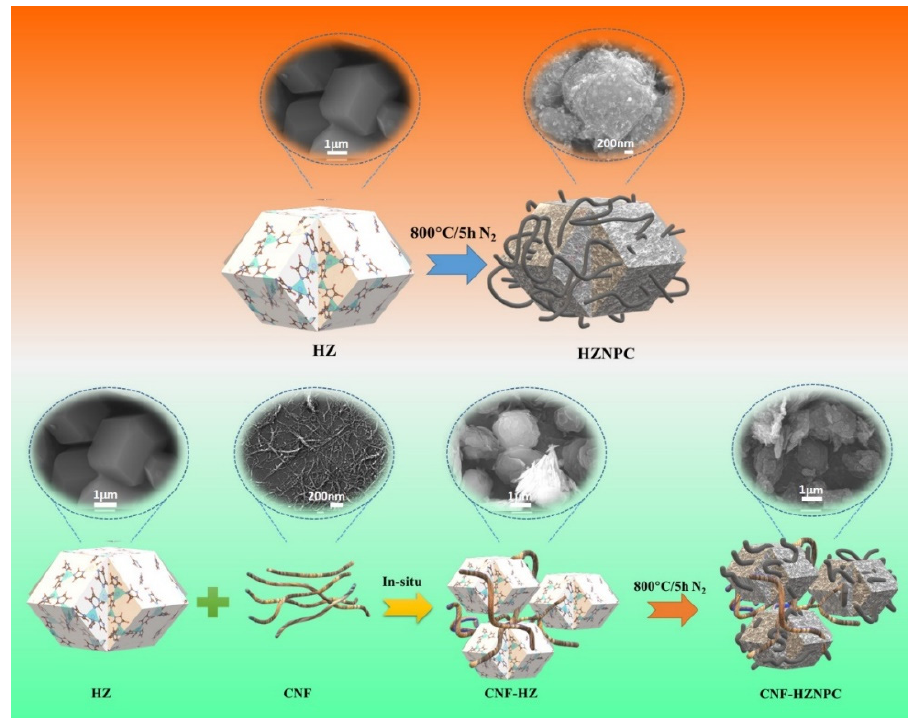
Figure 1. Schematic illustration of preparation of hybrid zeolite imidazole framework nanoporous carbon (HZNPC)and its composite with cellulose nanofibers (CNF).